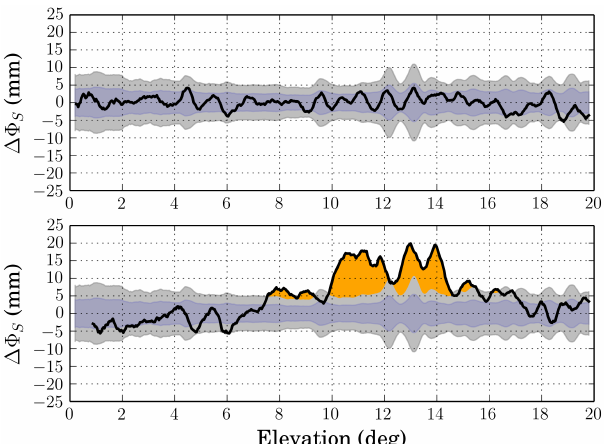
Figure 5. Examples of (cid:49)(cid:56) S ((cid:15)) (black line), the ± σ no-rain contour (blue) and the ± 2 σ no-rain contour (grey), for two observations of the PRN G22 on 26 May 2014 (top) and 14 June 2014 (bottom). The top (cid:49)(cid:56) S ((cid:15)) measurement is well inside the 2 σ contour, show- ing no polarimetric signatures. In the bottom panel, the case on 14 June 2014 shows large positive (cid:49)(cid:56) S ((cid:15)) . The value of (cid:49)(cid:56) S ((cid:15)) above the 2 σ no-rain threshold will hereafter be called (cid:49)(cid:56) + and its area (orange zone) will be denoted by A (cid:56) .